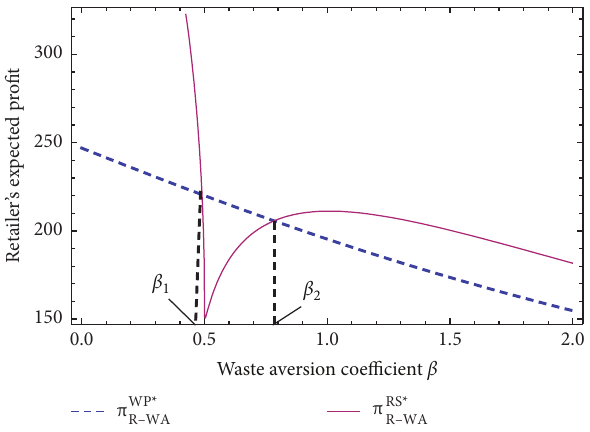
Figure 8: Effect of β on retailer’s expected profit.